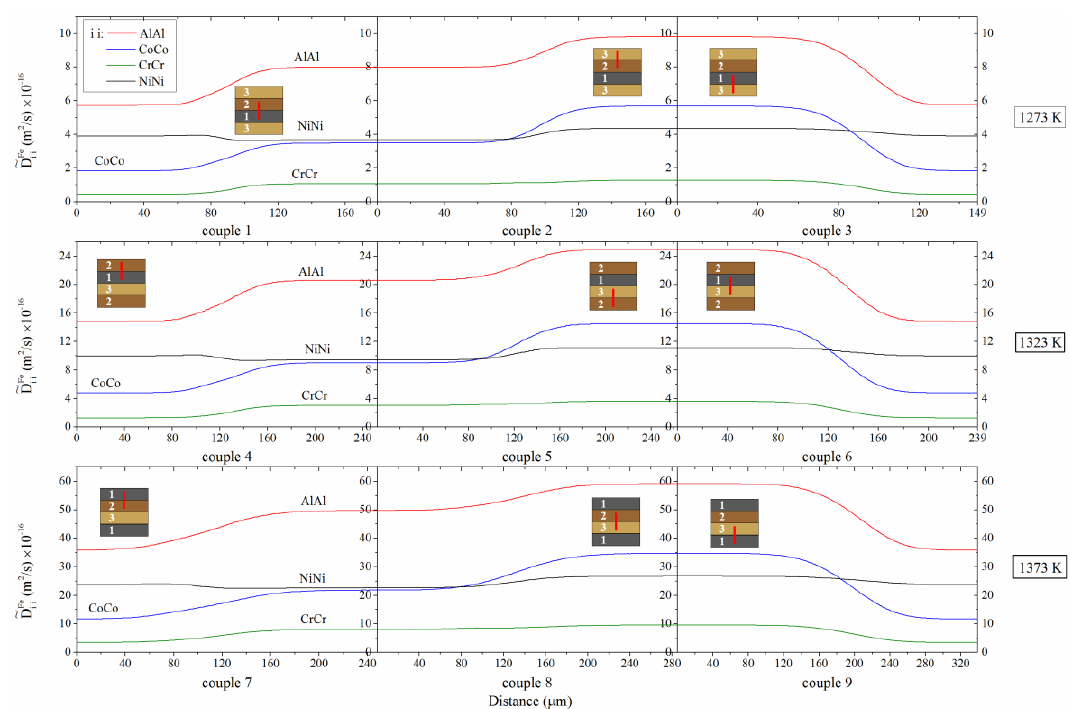
Figure 5. Comparison among the evaluated diagonal interdiffusivities for Al, Co, Cr, and Ni in the diffusion multiples annealed for 46 h at 1273 K, 1323 K and 1373 K, respectively, where Fe is taken as the dependent component.